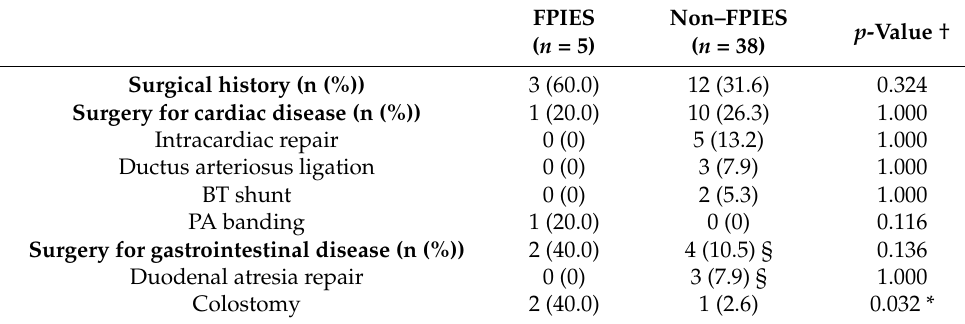
Table 2. Surgical history of children with DS.